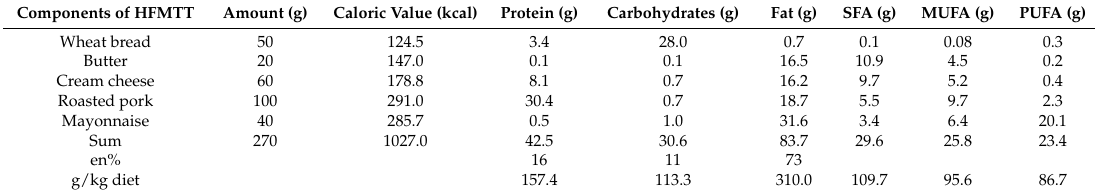
Table 1. Composition of high fat mixed meal tolerance test